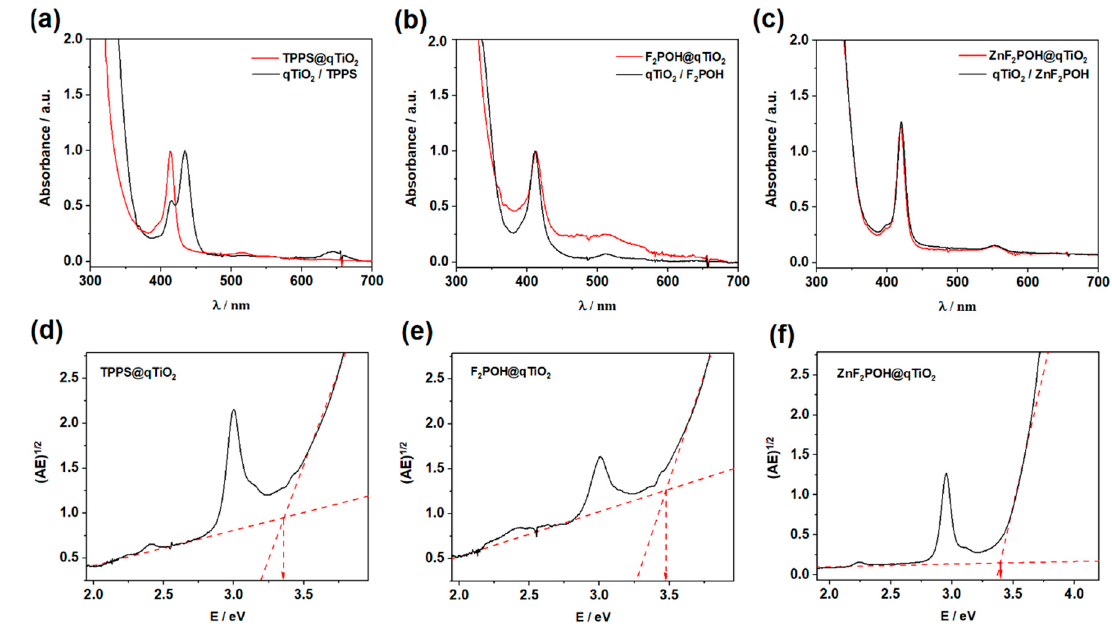
Figure 1. Absorption spectra of qTiO 2 overlap with porphyrin (black line) and obtained nanomaterials (red line) after mixing the colloidal solutions of qTiO 2 with studied porphyrins: TPPS, 5,10,15,20- tetrakis (2,6-difluoro-3-sulfophenyl)porphyrin (F 2 POH), 5,10,15,20- tetrakis (2,6-difluoro-3-sulfophenyl)porphyrin Zn(II) (ZnF 2 POH) ( a – c ), and the estimation of the band gaps energy for each material based on the Tauc plot with baseline correction ( d – f ).